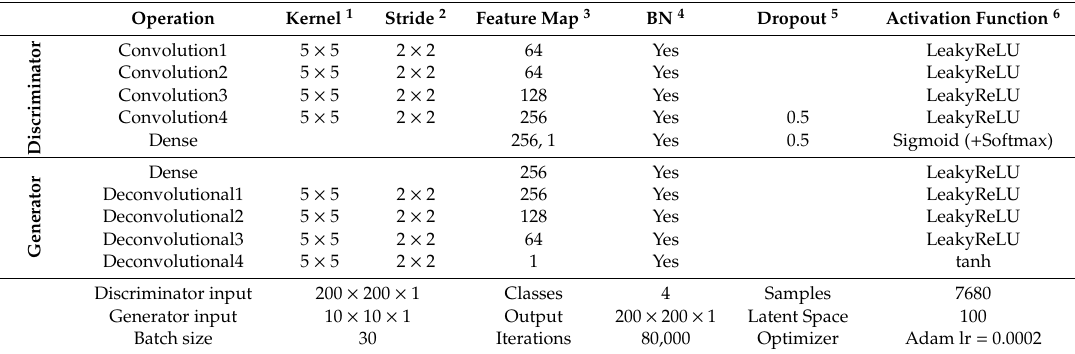
Table A1. ACGAN Model